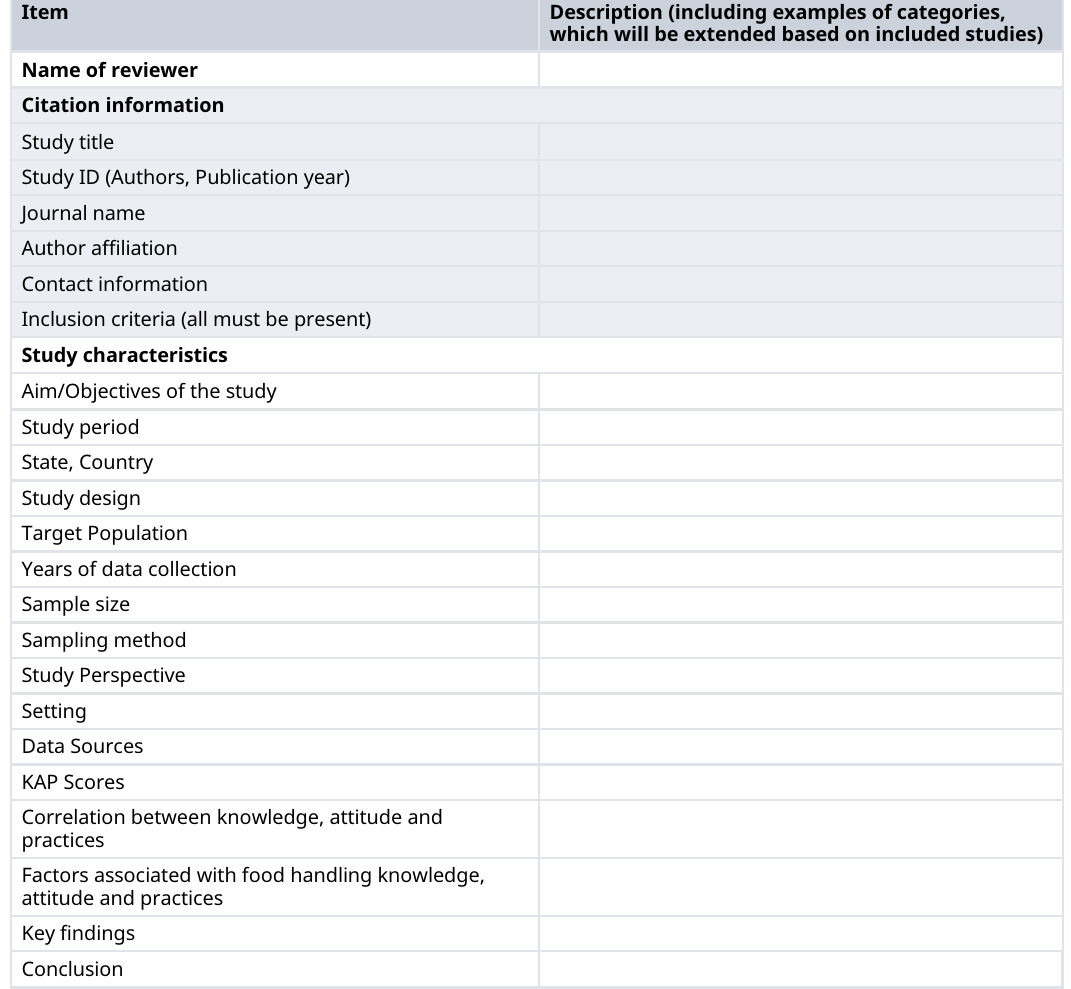
Table 2. Data extraction/charting sheet.